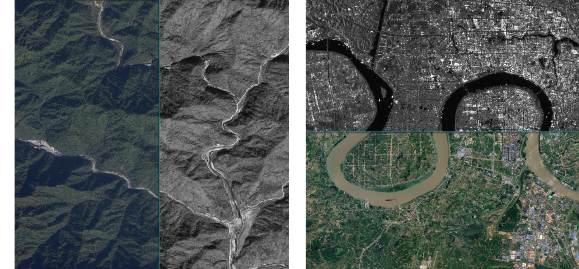
Figure 1. Example of multimodal images with direct georeferencing. (a) Google (Left) and GaoFen-2 Panchromatic (Right) images. (b) Google (Nether) and Sentinel-1 SAR (Upper)